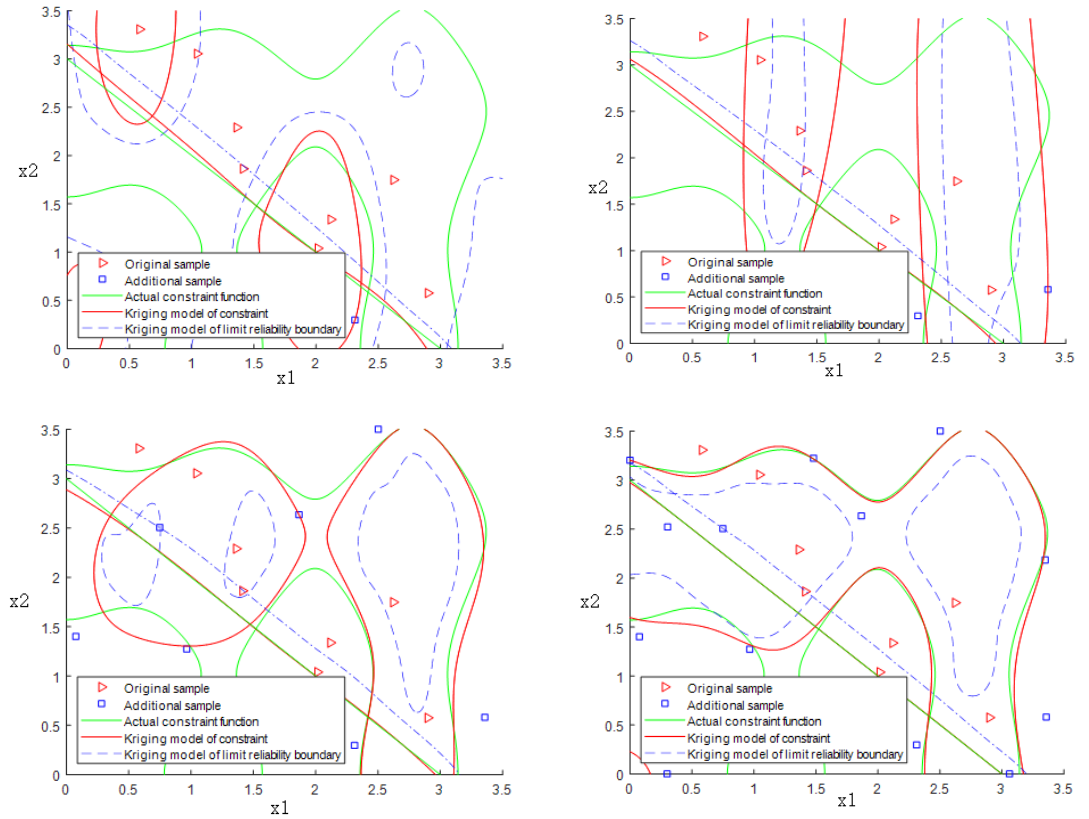
Figure 6. Optimization process of the Haupt